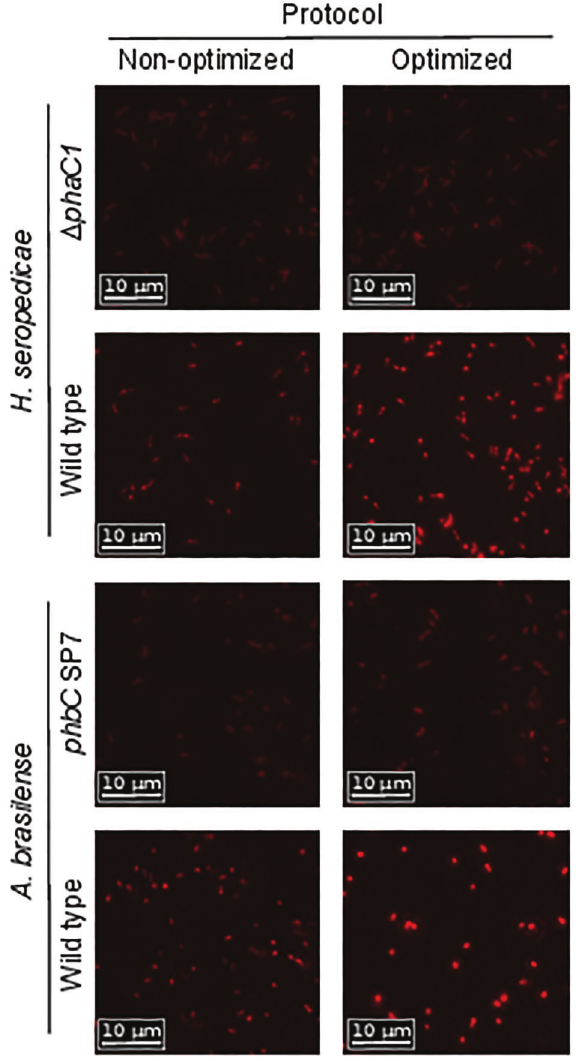
Figure 6. Intracellular PHB detection by fl uorescence microscopy using the non-optimized and optimized protocols. H. seropedicae strain SmR1, a mutant strain of H. seropedicae , D phaC1 , A. brasilense strain FP2, and a mutant strain of A. brasilense , phbC SP7 were grown to OD 600 of 1.4 using 5 mM NH 4 Cl in growth medium. Fluorescence microscopy analysis was performed using the procedure described in the Material and Methods. using buffers containing ethanol (9), or sucrose-based buffers, such as the TSE buffer (10).